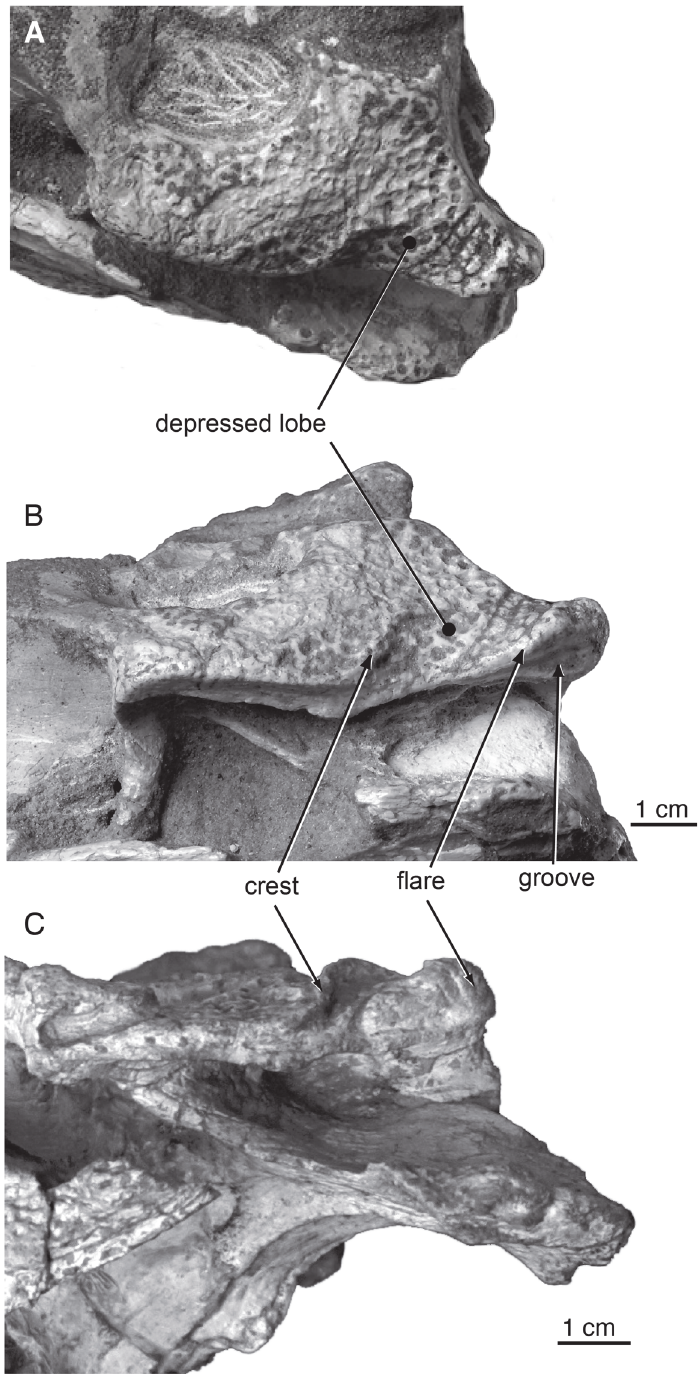
Fig 4. Skull morphology of Paralligatoridae. A , Shamosuchus djadochtaensis , AMNH FARB 6412, dorsal view; B , S . djadochtaensis , AMNH FARB 6412, left lateral view; C , S . ulanicus (= Paralligator gradilifrons ), PIN 3140-502, left lateral